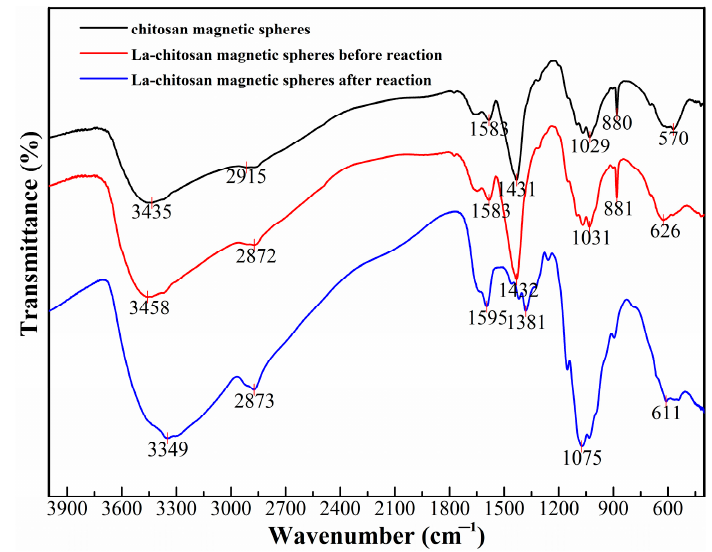
Figure 4. FTIR spectra of chitosan magnetic spheres and La-chitosan magnetic spheres before and after reaction.